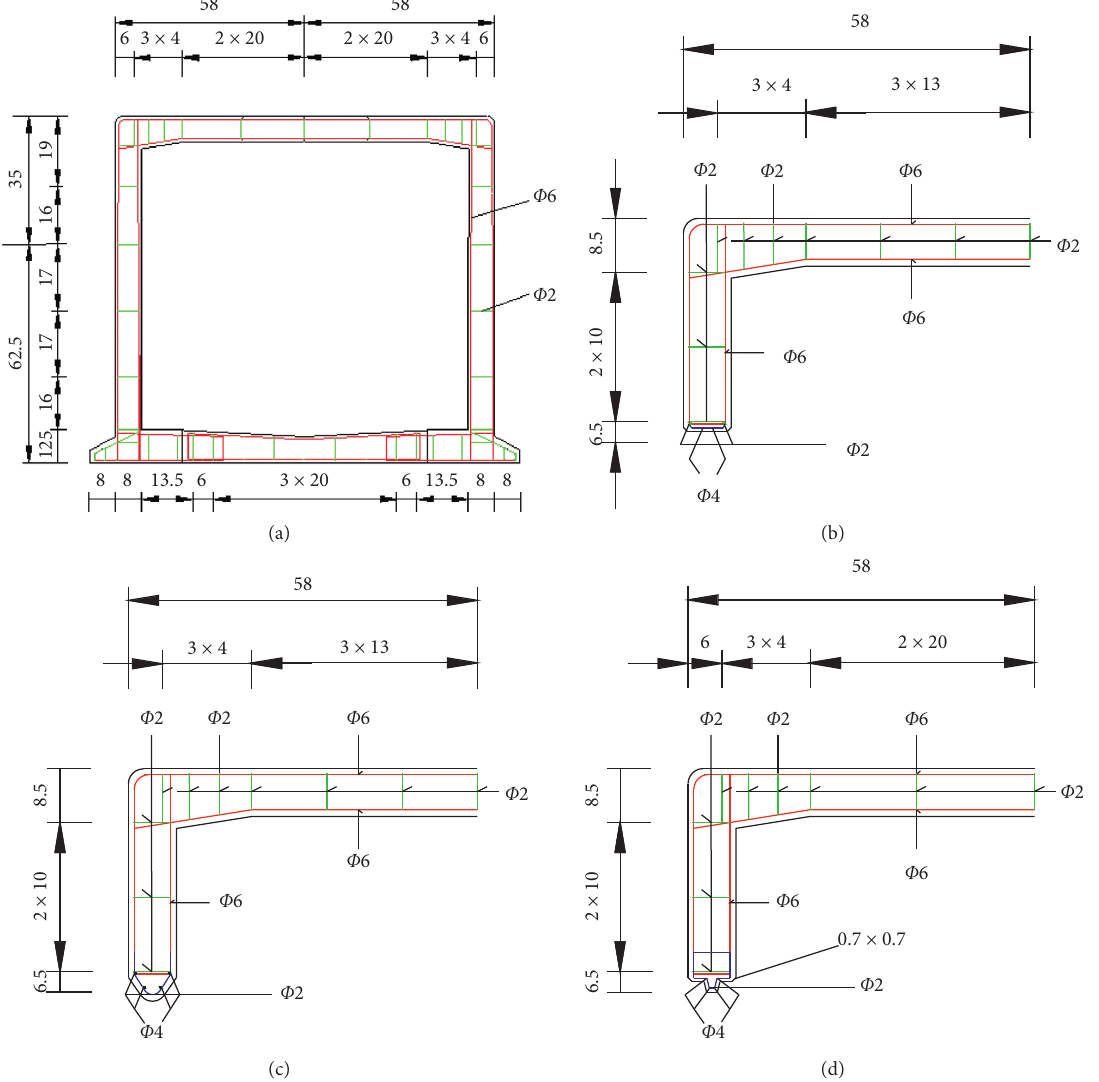
Figure 2: Structural design of prefabricated BCs (unit: cm). (a) Integral type. (b) Feature of hinged joint of flat seam type. (c) Feature of hinged joint of round hinged type. (d) Feature of hinged joint of mortise type.